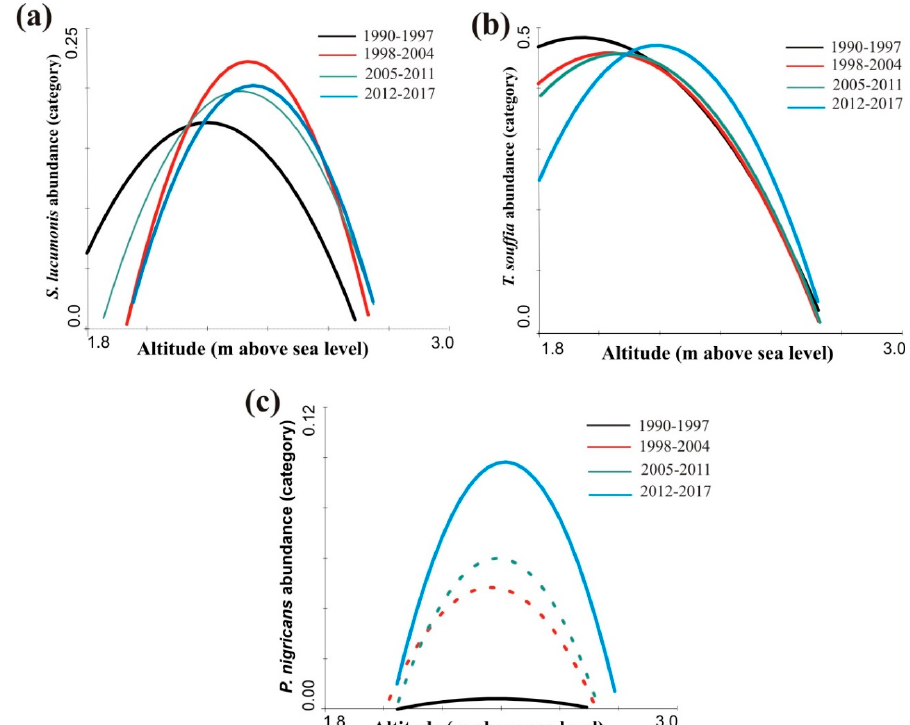
Figure 8. The effects of altitude on the abundance of ( a ) Squalius lucumonis , ( b ) Telestes muticellus and ( c ) Padogobius nigricans over the census periods 1990–1997, 1998–2004, 2005–2011, 2012–2017. Solid lines indicate significant results from the general linear model (GLM).